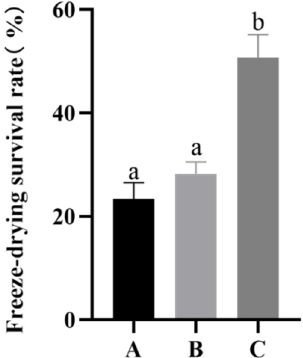
Figure 3. The freeze-drying survival rate of B. longum CCFM 1029 under different culture conditions. A is the common osmotic pressure culture group; B is the common osmotic pressure culture group supplemented with 21 g/L proline; C is the higher osmotic pressure culture group supplemented with 21 g/L proline. Columns with different letters indicate significant differences ( p < 0.05).